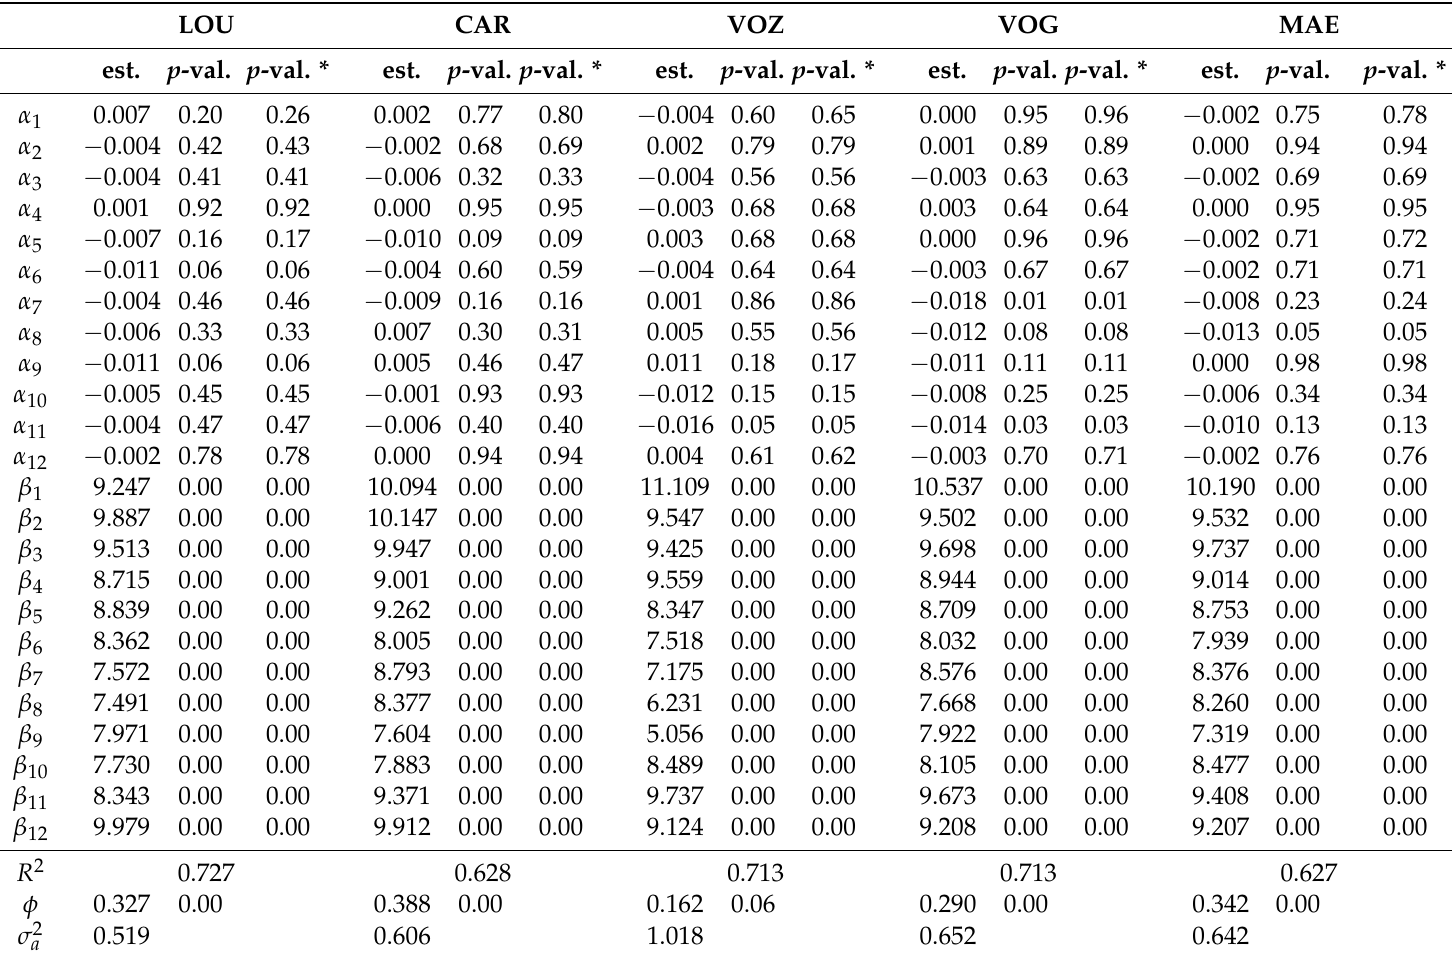
Table 3. Results for the MI model for dissolved oxygen (DO) concentration at the different locations.